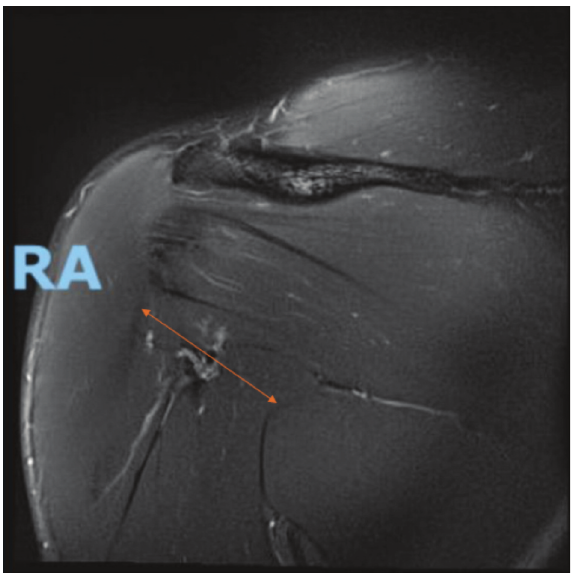
MRI coronal view of right chest showed complete PMT Fig. 2: rupture and medialisation of muscle belly. Lower PM is retracted and leaving a 5cm